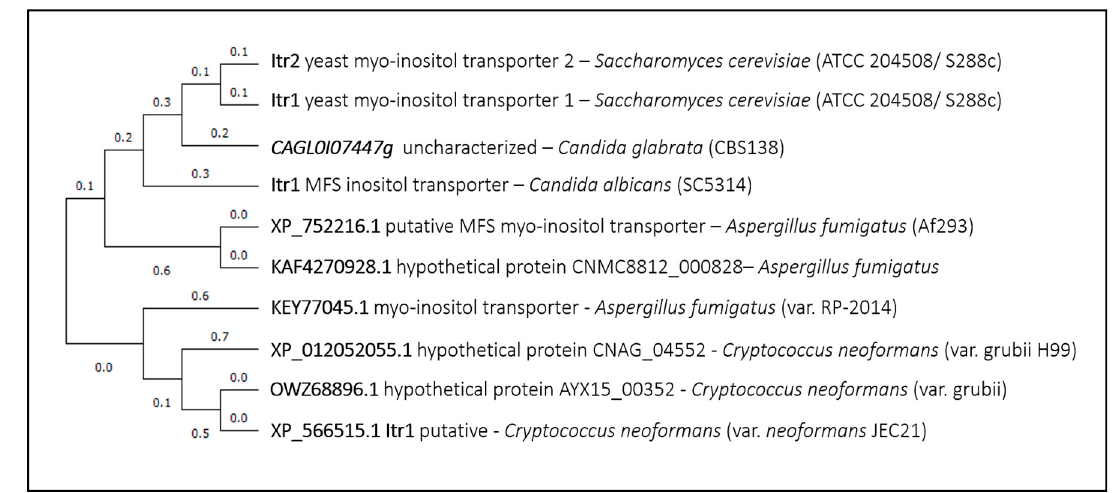
Figure 1. Itr1 phylogenetic analysis. The tree with the highest log likelihood is shown. This analysis involved 10 amino acid sequences. There were a total of 635 positions in the final dataset. Evolutionary analyses were conducted in MEGA X (https://pubmed.ncbi.nlm.nih.gov/29722887/).